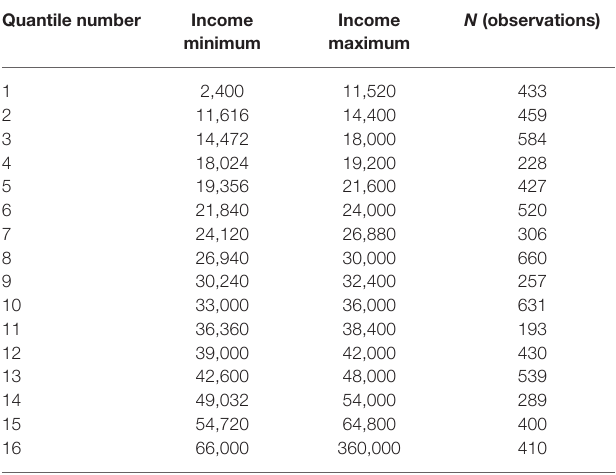
TABLE 2 | The range and number of person-year observations of the GSOEP Income 4 variable divided into 16